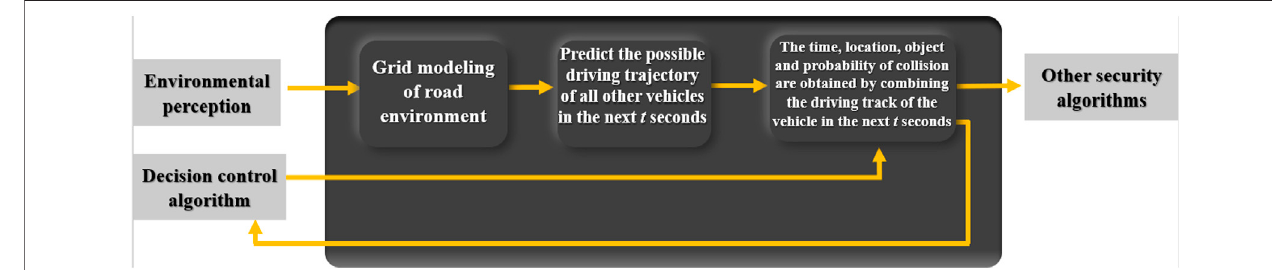
FIGURE 2 | Overall calculation process of risk assessment framework.